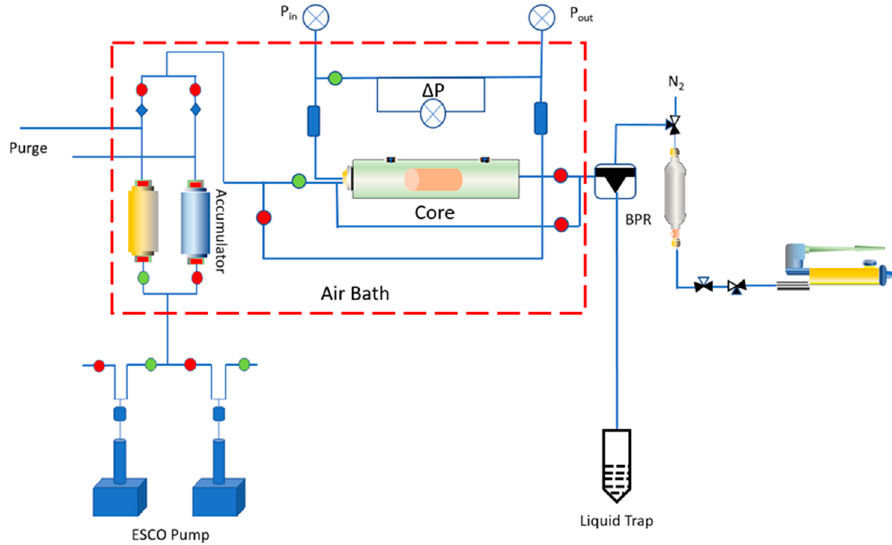
Figure 1. The schematic diagram of the Sc-CO 2 flooding system.